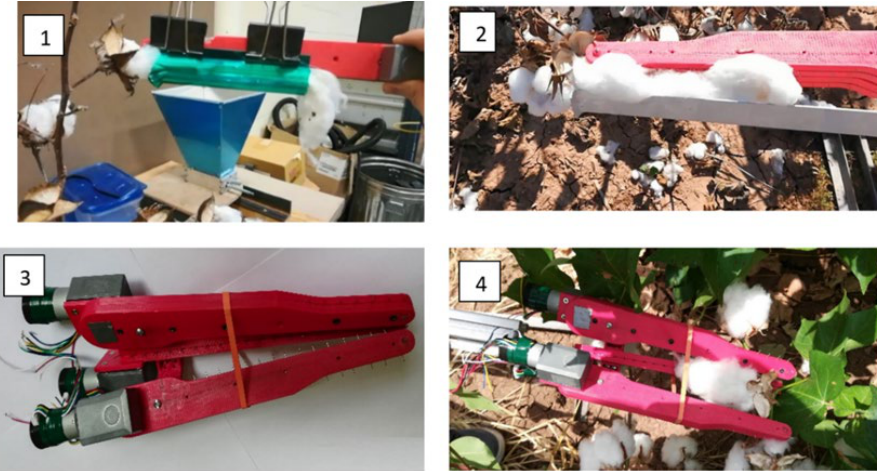
Figure 2. Image 1 : one-finger end-effector; image 2 : one-finger end-effector; images 3 and 4 : three-finger end-effector [73]. Adapted from Gharakhani and Thomasson (2021).